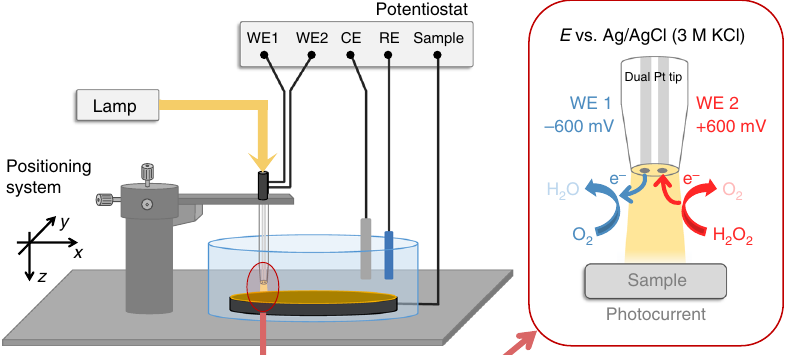
Fig. 2 The PS1/redox polymer-based photocathode is investigated using SPECM. Representation of the SPECM setup. CE: counter electrode, RE: reference electrode, WE: working electrode. Right: dual Pt microdisk tip for the simultaneous collection of O 2 and H 2 O 2 while allowing localized irradiation of the sample through the glass sheath of the positioned dual microelectrode tip